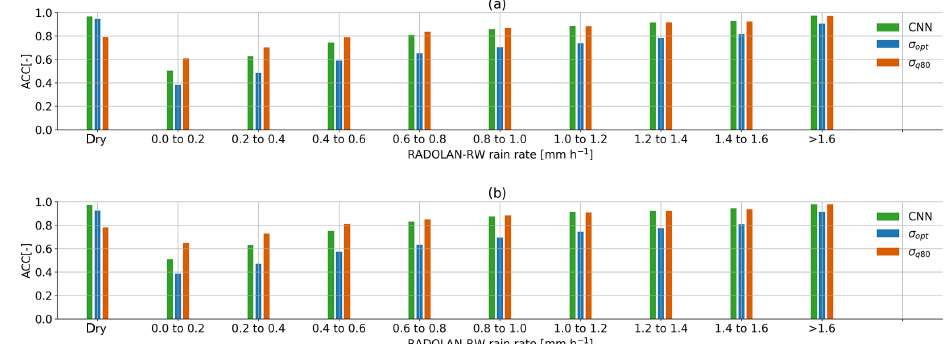
Figure 7. Each bar shows the ACC score on samples from (a) VALAPR and (b) VALSEP, grouped by the reference rain rate. An ACC of 0.5 represents random